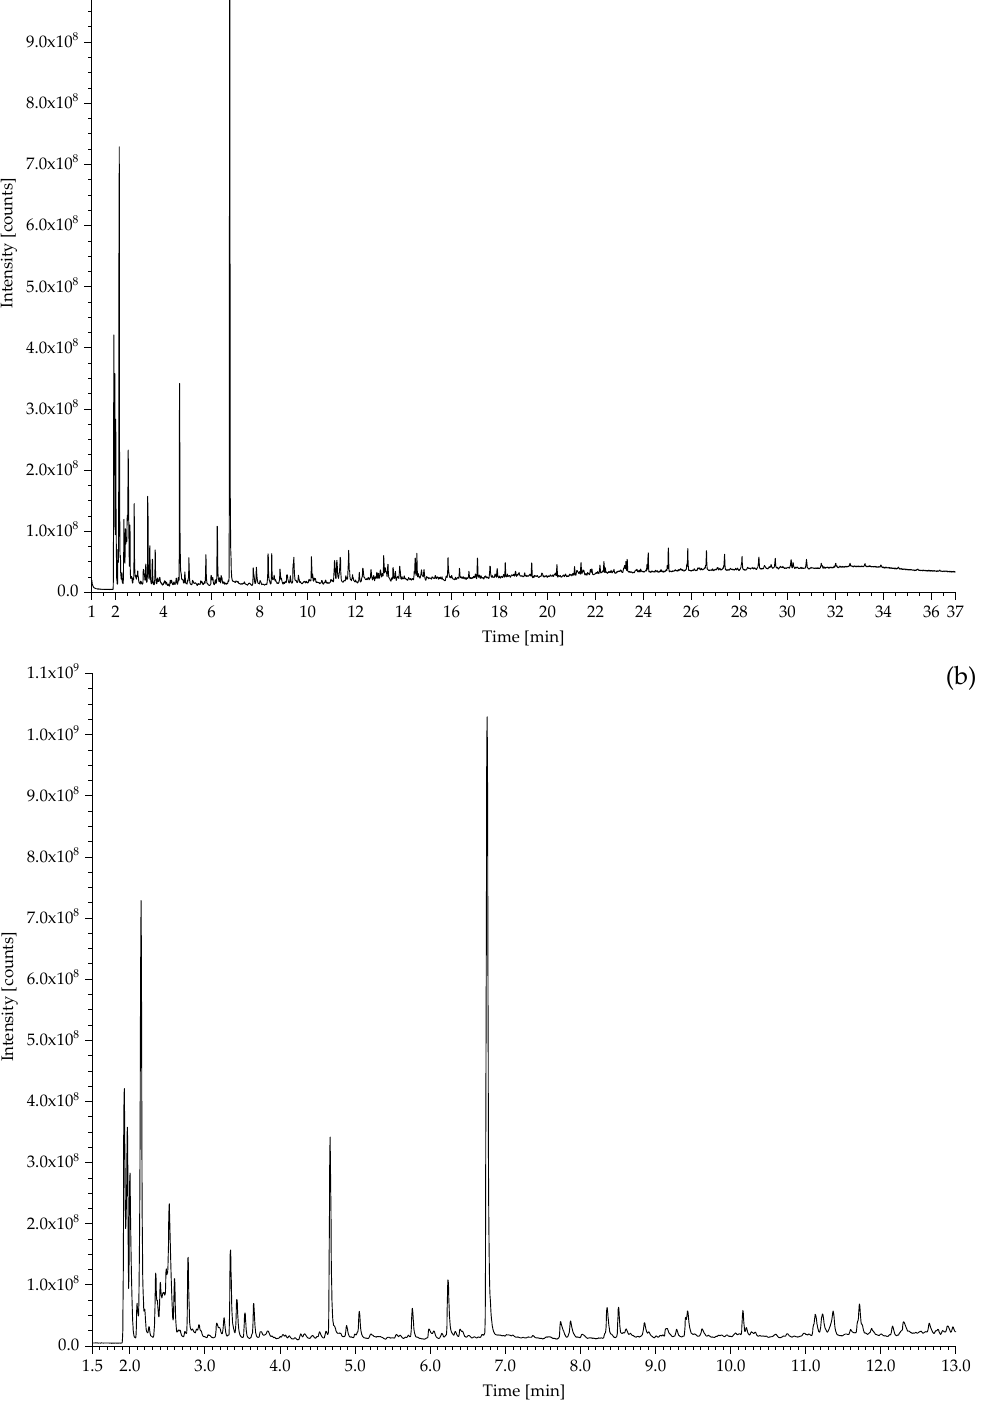
Figure 10. Pyrogram of sample 383 ( a ) and a zoomed ‐ in view of the same pyrogram ( b ).